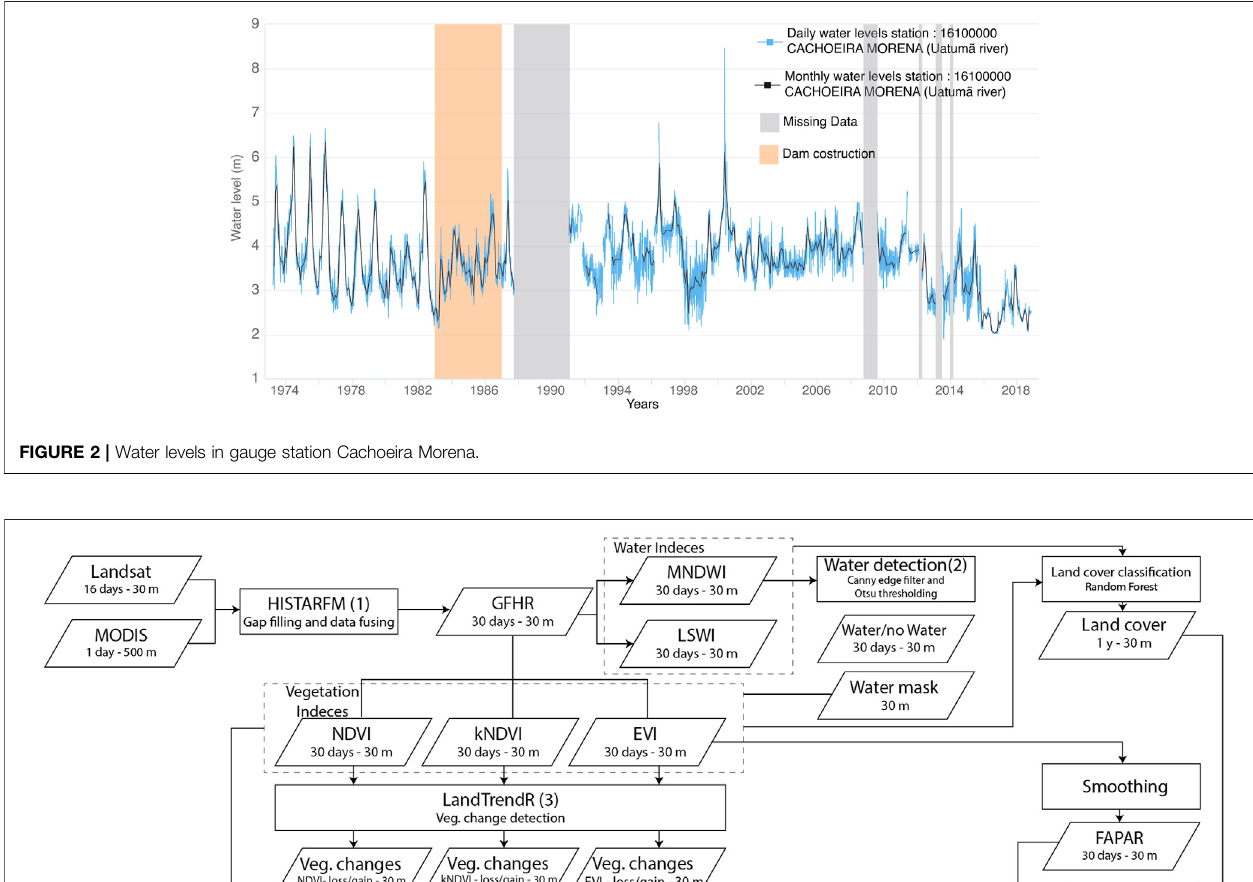
Frontiers in Environmental Science |